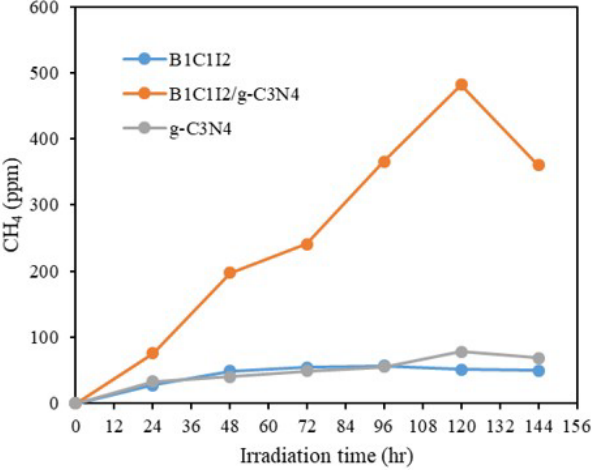
Figure 7. Photocatalytic reduction of CO 2 as a function of irradiation time over B1C1I2, B1C1I2/g- C 3 N 4, and g-C 3 N 4 .